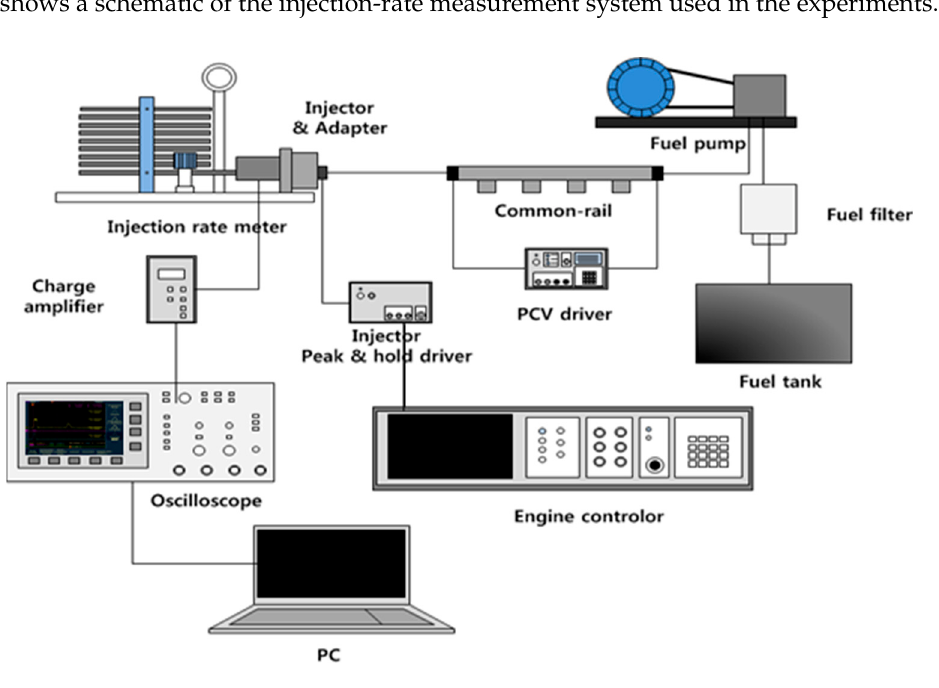
Figure 1. Schematic of injection-rate meter system (PCV: pressure control valve).